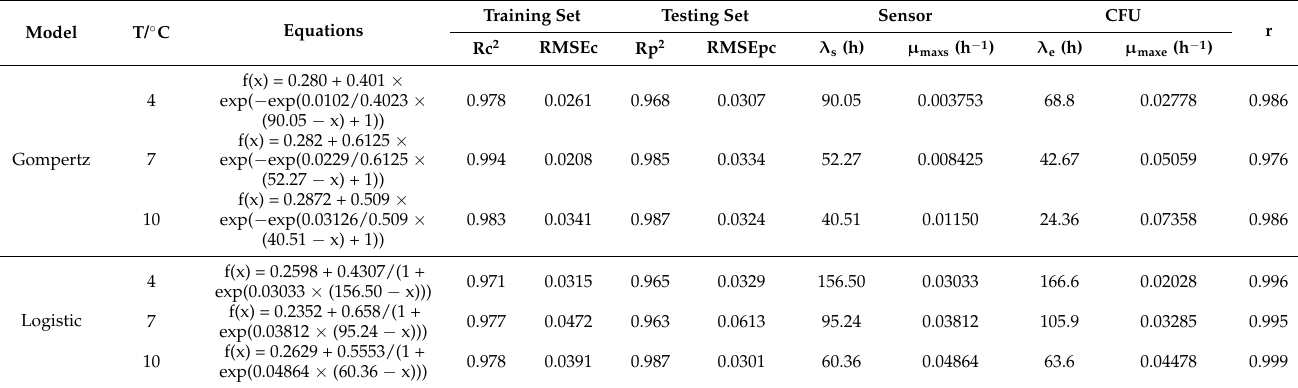
Table 2. Parameters of dynamic growth models of S. putrefaciens in tuna stored at different temperatures based on P30/2 by modified Gompertz and logistic